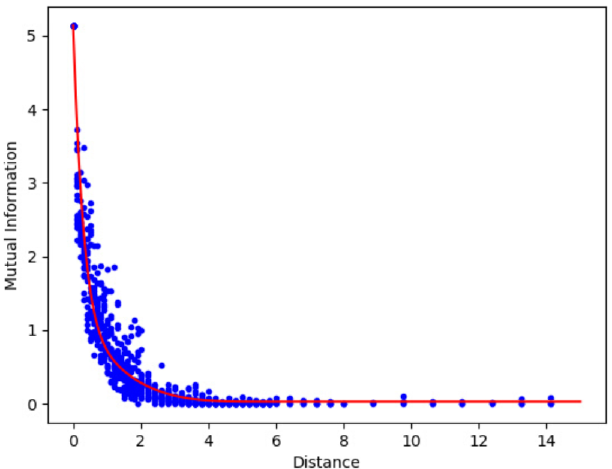
Figure 2. Mutual information I ( X i , X j ) as a function of the distance || ξ i − ξ j || 2 .